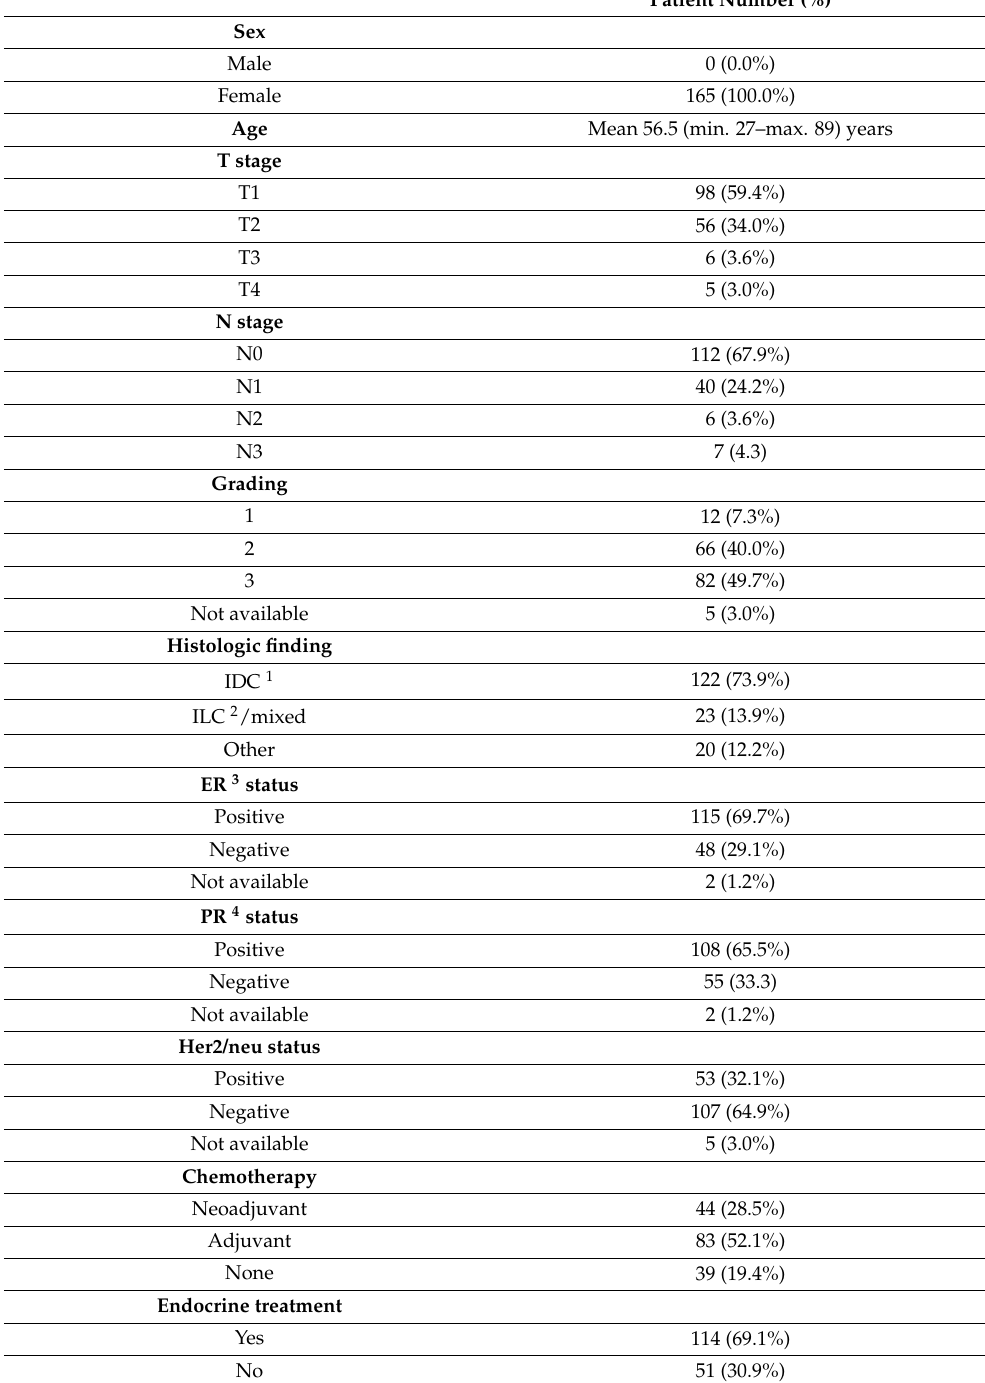
Table 1. Patient and disease